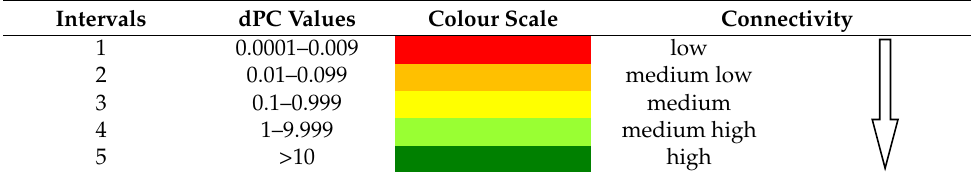
Table 1. Classification of dPC values according to intervals and red-to-green colour scale. Intervals dPC Values Colour Scale Connectivity